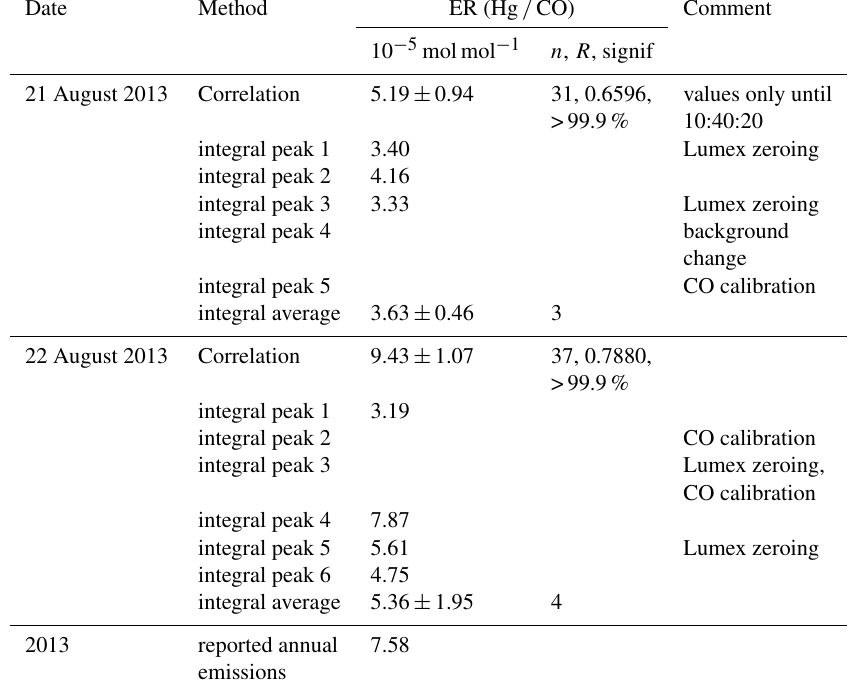
Table 3. Hg / CO enhancement ratios (ERs). Correlation method: 10s average Hg concentrations measured by Lumex correlated with 10s average CO mixing ratios for SO 2 mixing ratios above 10ppb with uncertainties set to 1ngm − 3 for Lumex and 1ppb for CO. Integral method: 1s Lumex and CO signals integrated over the duration of Lumex measurement, readings of Tekran with quartz wool taken as Lumex background concentrations (i.e., 1.27 and 1.25ngm − 3 for 21 and 22 August, respectively). CO background mixing ratio was 119.3ppb